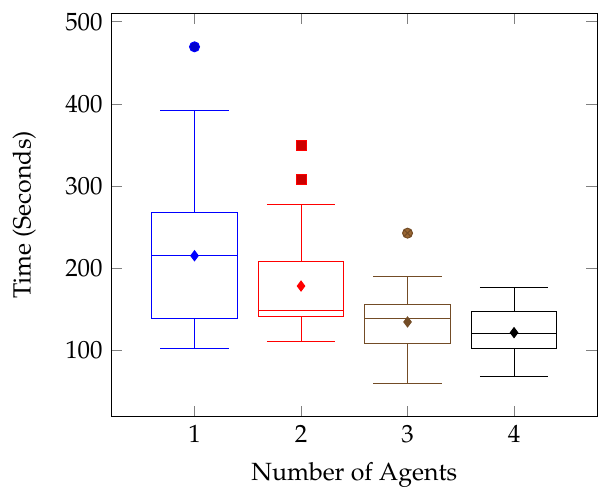
Figure 15. Number of Agents vs. Time (Seconds)-All Target Locations in Test Environment Two.